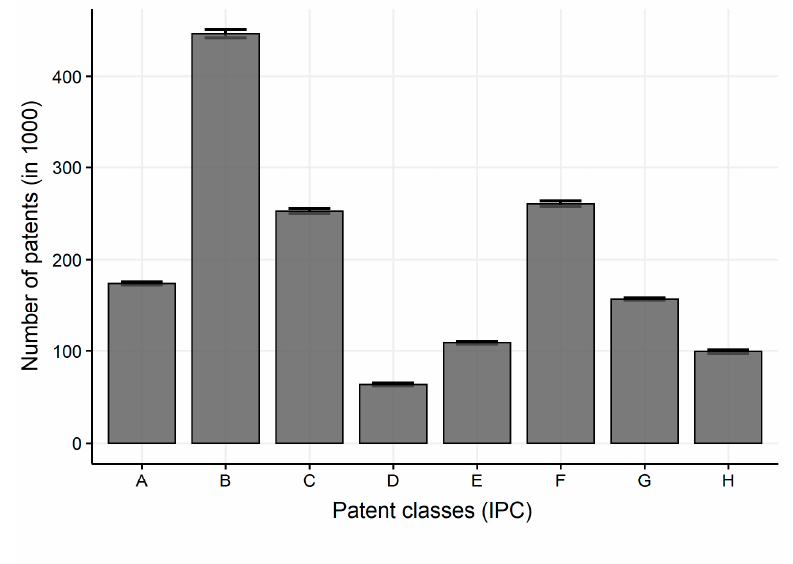
Figure A7. Sectoral distribution of patents (average over runs)